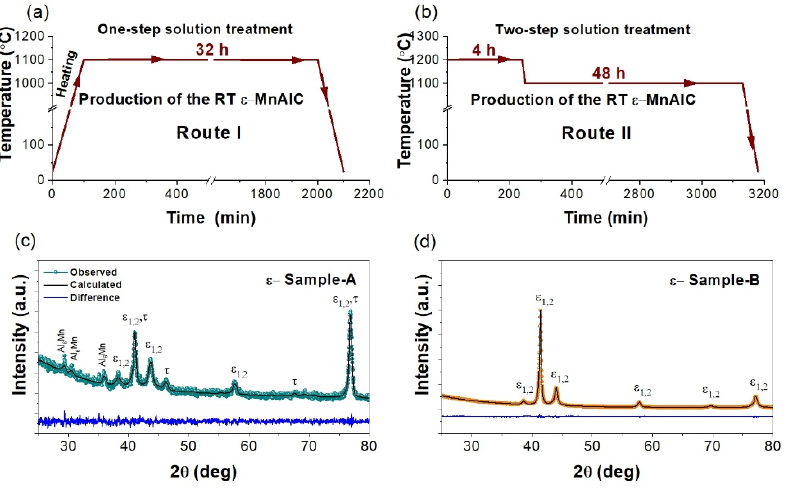
Figure 1. Schematic representation of the solution treatment routes: ( a ) Route I and ( b ) Route II. XRD pattern taken on the resulting samples from ( c ) Route I ( ε -Sample-A) and ( d ) Route II ( ε